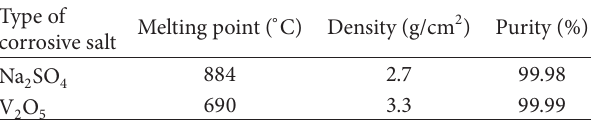
Table 2: The physical specifications of corrosive